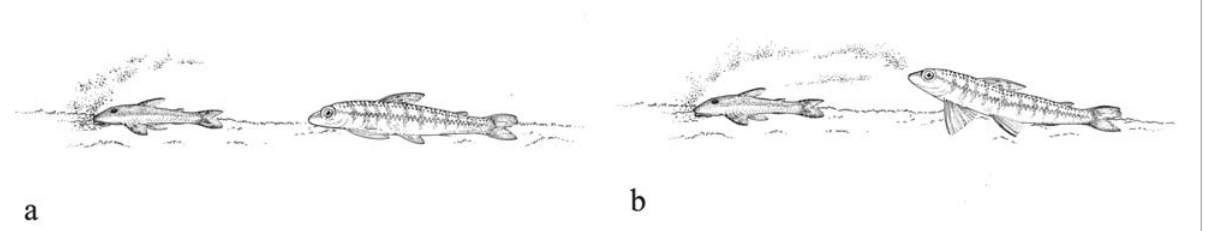
Fig. 2. The grazing activity of Parotocinclus maculicauda that dislodges particles, resulting in small clouds (a); and Characidium sp. standing downstream of the foraging catfish, adopting a sit-and-wait foraging tactic to feed on the particles (b). Illustration by A.